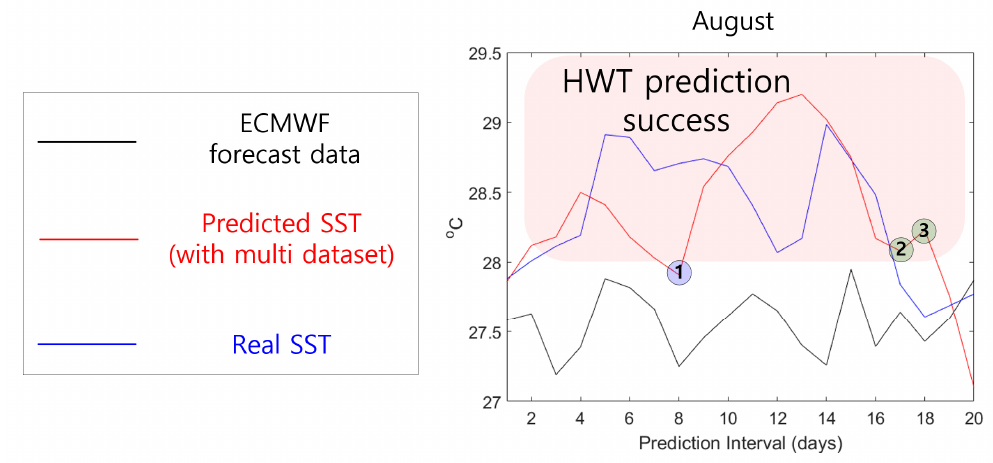
Figure 14. Comparison of SST and HWT prediction performance between the proposed model (with multi-dataset input) and European Center for Medium-Range Weather Forecast (ECMWF) forecast data.